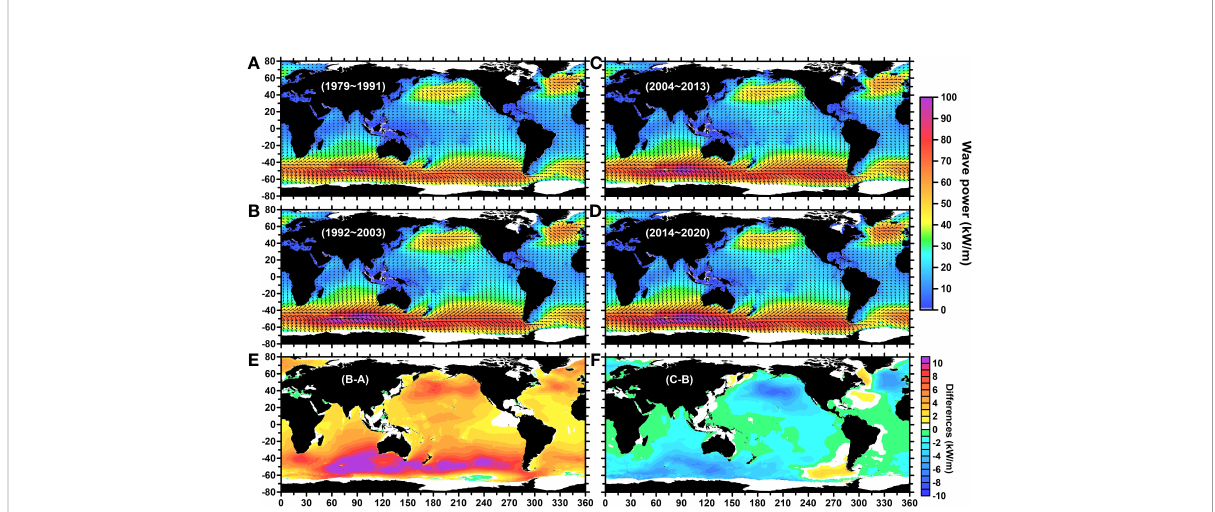
FIGURE 4 Year-averaged global wave power fi elds and decadal variability. (A) Averaged wave power from 1979 to 1991, (B) from 1992 to 2003, (C) from 2004 to 2013, and (D) from 2014 to 2020. (E) The averaged differences in wave power between (A) and (B) ; and (F) the averaged differences in wave power between (C, B)